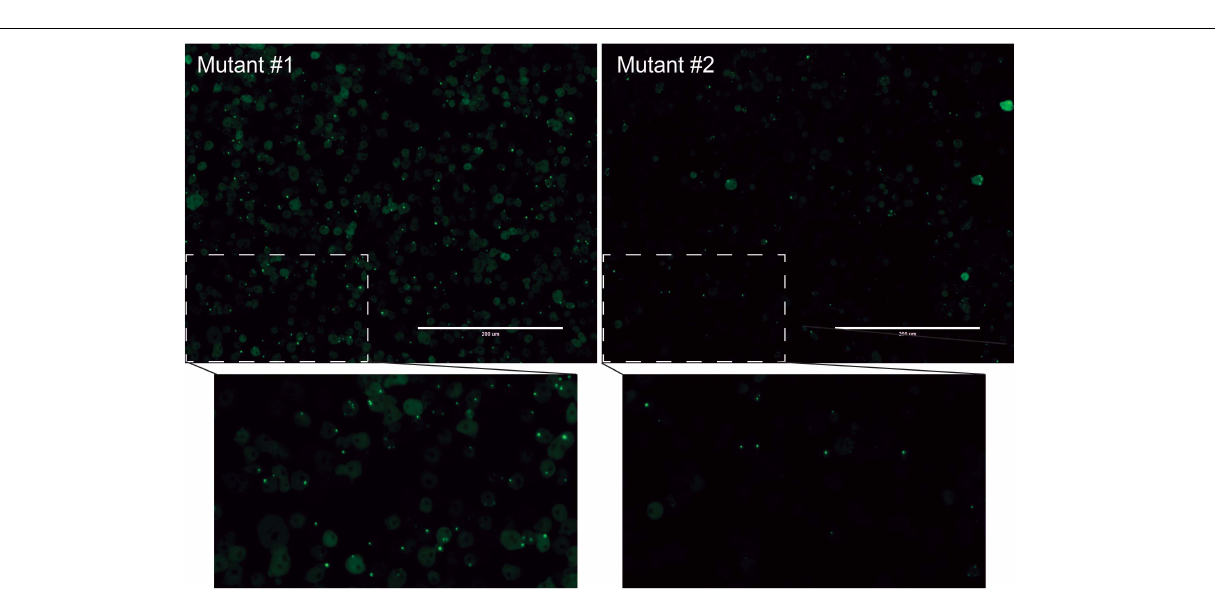
FIGURE 5 | Two protein aggregation mutants obtained using this selection technique. Mutagenized and 5-FOA selected cells were plated on SM agar plates containing bacterial lawns. Colonies were isolated following plaque formation. After 48 hours of growth, cells were analyzed for GFP puncta using an EVOS